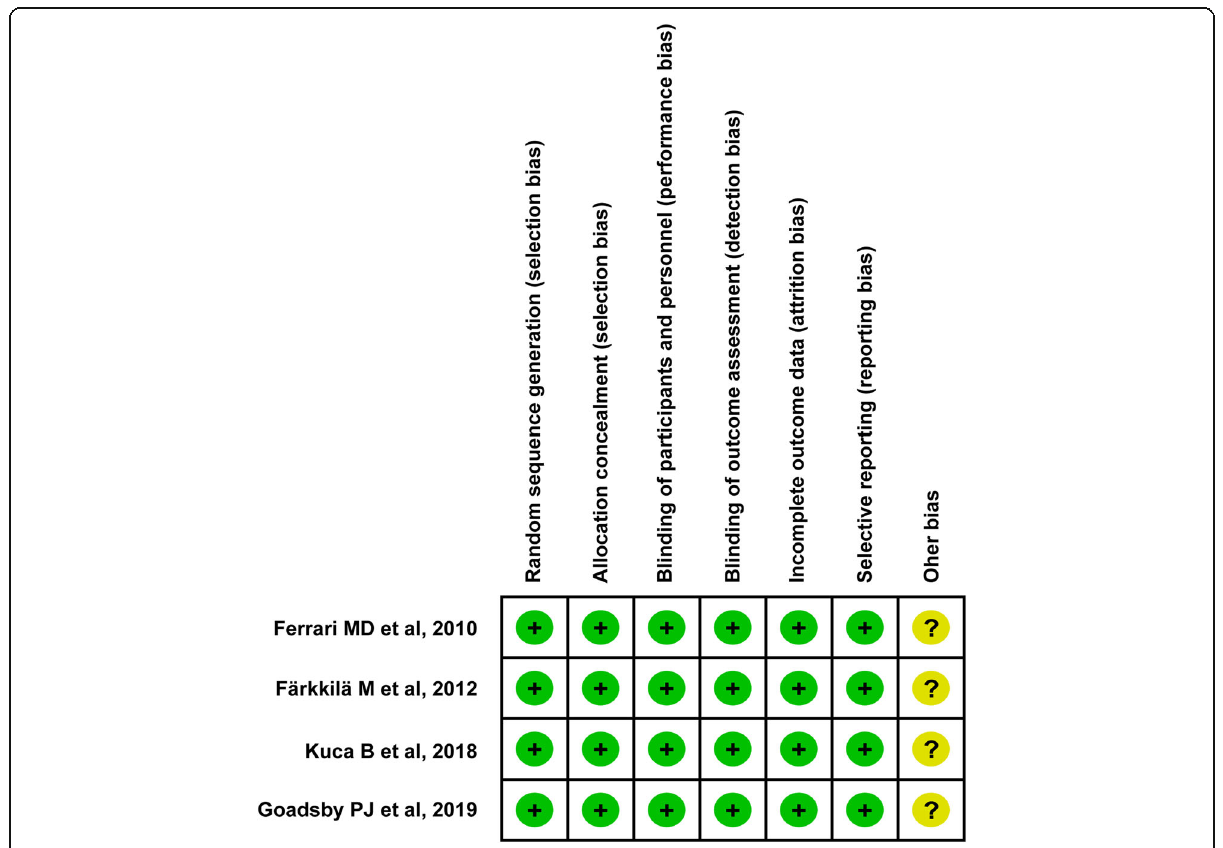
Fig. 2 Risk of bias for included